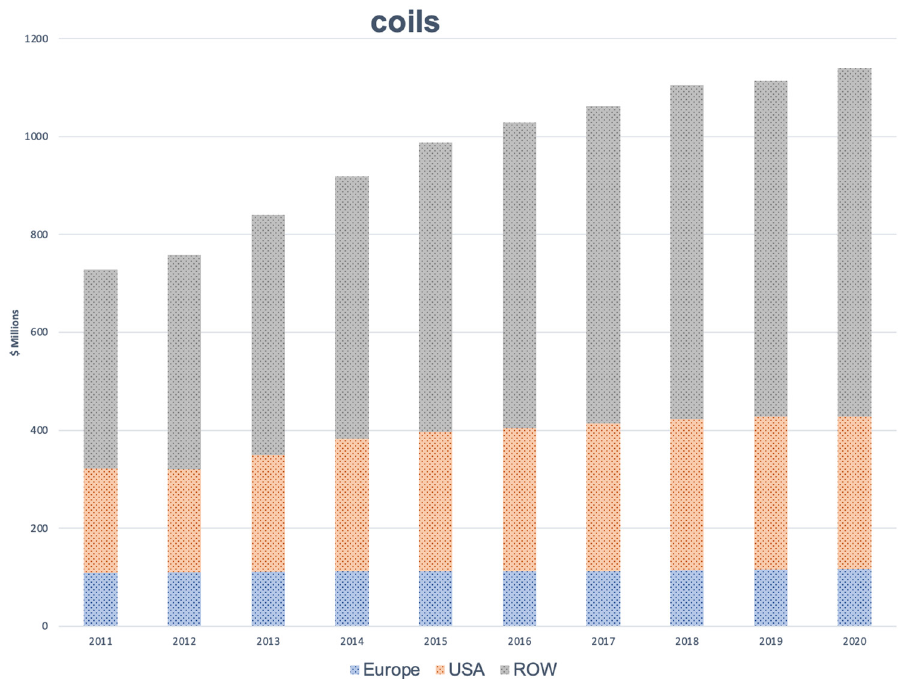
Figure 1. Annual revenues (in millions USD) associated with the use of endovascular coils in Europe, the USA, the rest of the world (ROW), and globally (totals) from 2011 through 2020. Data were collected from industry sources.